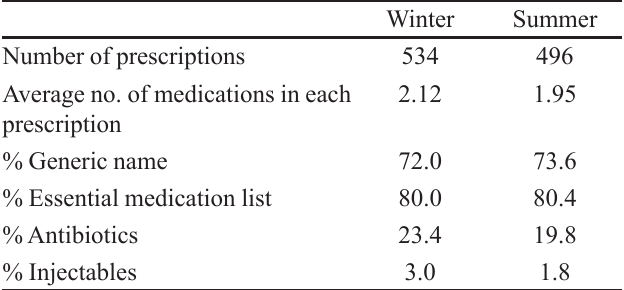
Table I. Similarly, in the study of Oliveira et al. (2009) it was observed that most prescriptions also had only one medication prescribed. However, in the Ev, Guimarães and Castro (2008) study, 34.27% of the prescriptions had one medication prescribed and 34.37% had 2 medication prescribed, thus differing from the present study.